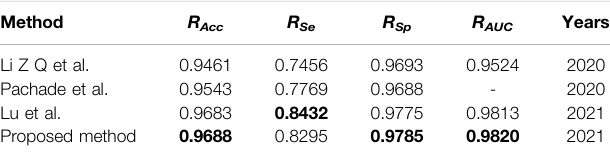
TABLE 2 | Segmentation performance comparison of different algorithms on STARE.